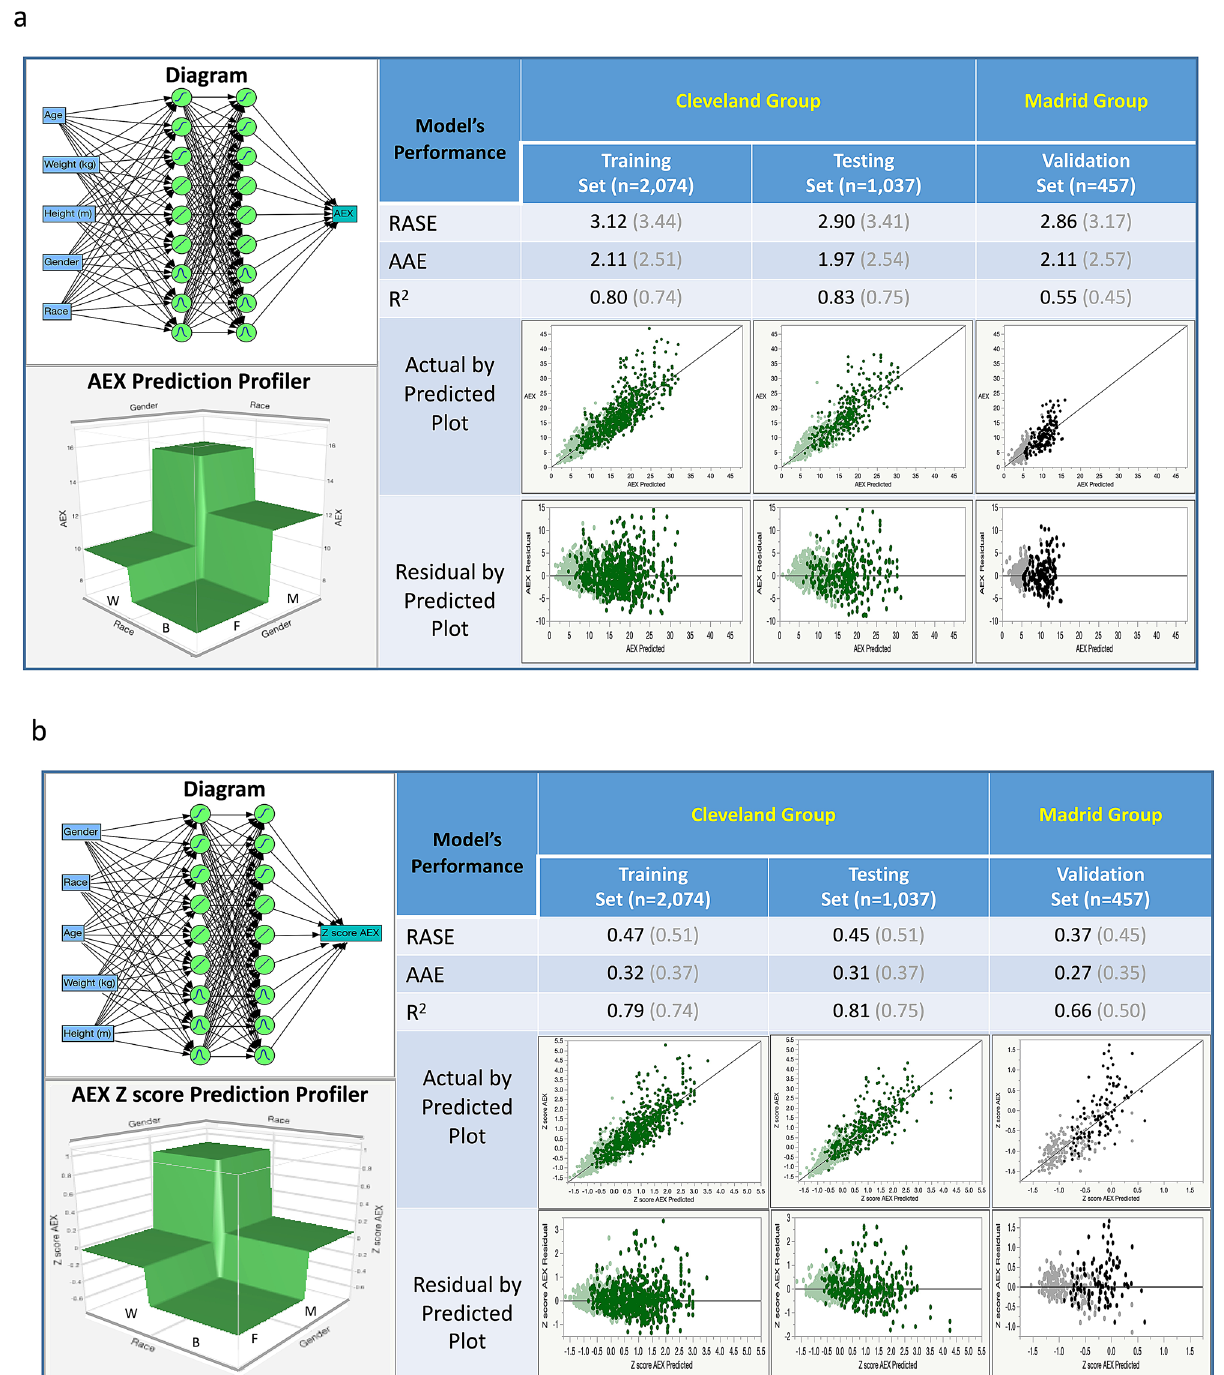
Figure 5. Machine learning (artificial neural network) models predicting AEX ( a ) and AEX z scores ( b ) using as inputs gender, race, age (years), weight (kg) and height (m). Left upper corner shows the model diagram, while left lower corner illustrates the prediction profiler by gender and race. The main table reveals the high performance of the model predicting AEX/Z scores in all subject groups (derivation, internal and external validation sets), with a ‘cohort effect’—a drop in the generalized R 2 from internal to external validation sets. For comparison, the R 2 , RASE and AAE of the regression model are shown in grey (in brackets). Color codes— green: Cleveland group; black/grey: Madrid group. dark colors (green and black): males; light colors (green and grey): females. AEX area under expiratory flow-volume curve, B black, W white, F female, M male, AAE average of absolute error, R 2 R squared statistic, RASE square root of the mean squared prediction error, calculated as the square root of the sum of squares error divided by